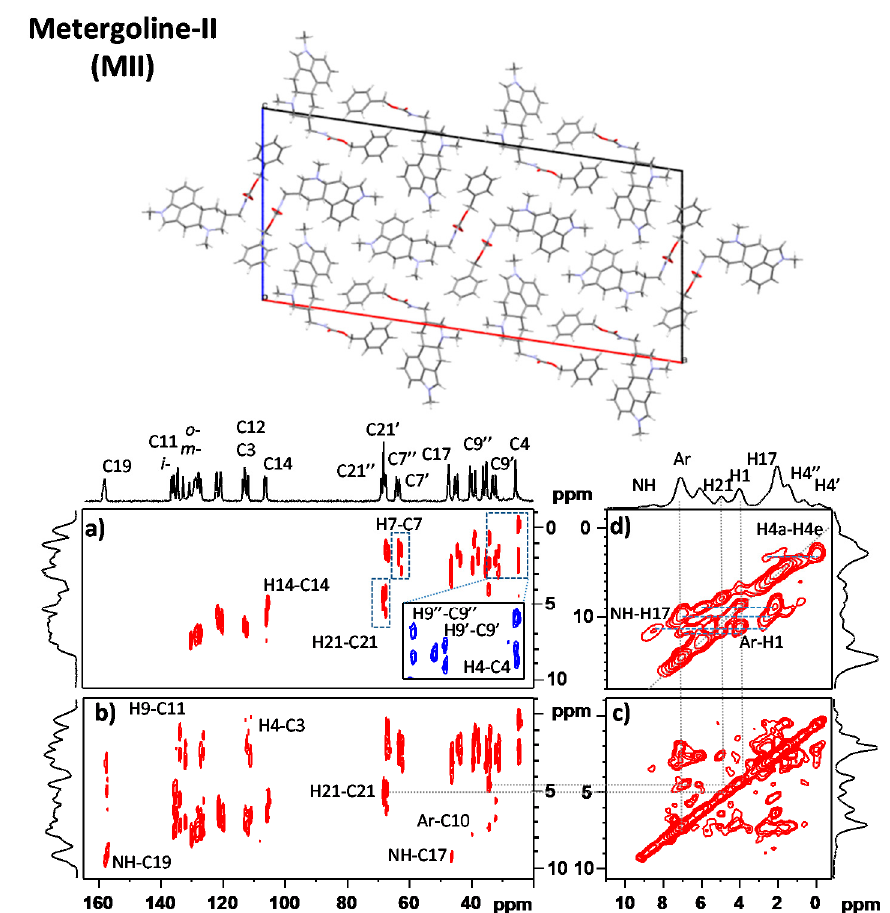
Figure 3. XRD crystal structure [21] 2D 1 H– 13 C FSLG HETCOR NMR spectra of MII measured with 100 and 300 μ s CP mixing times are shown in panels ( a , b ), respectively; 2D 1 H– 1 H CRAMPS NMR spectrum of MII measured with a 25 μ s spin-diffusion period ( c ); and 2D 1 H– 1 H DQ/SQ CRAMPS NMR spectrum of MII measured with a 40 μ s recoupling period ( d ). Upper projections are provided by 1D 13 C CP/MAS and 1 H CRAMPS NMR spectra. The connectivity of individual structural units is indicated. For the full-size spectra, see Supporting Information (SI-Experimental details.pdf).